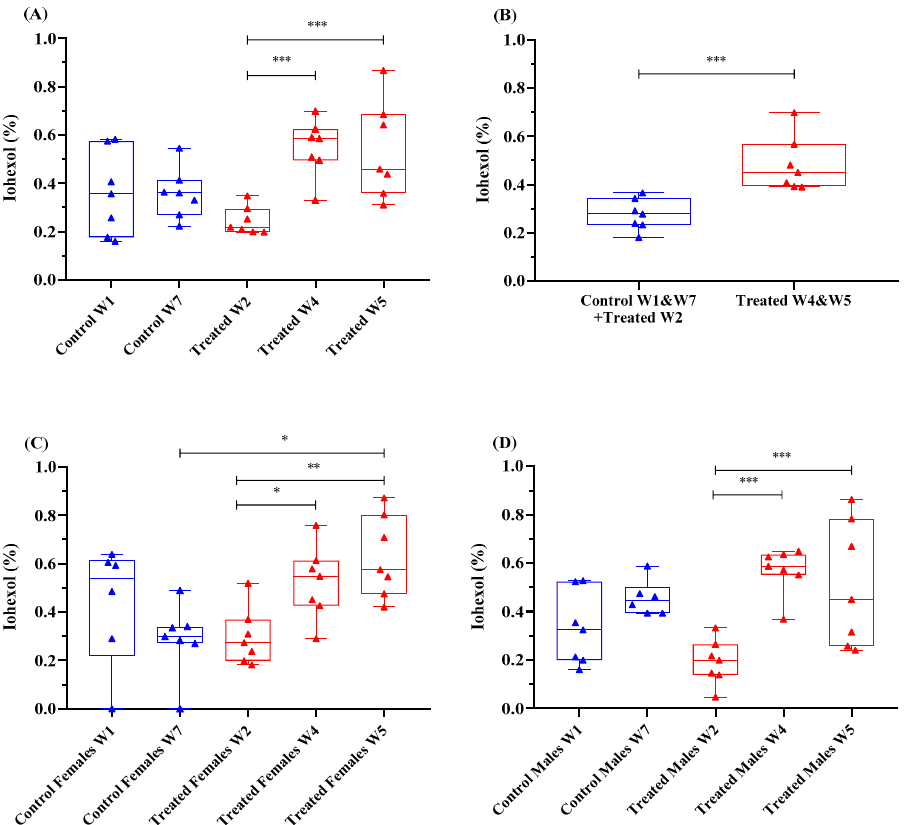
Figure 3. Urinary excretion of iohexol (%) during 24 h following oral administration in all mice ( A , B ) and ( C ) female and ( D ) male mice over 24 h, with data combined for the 7 weeks of intestinal permeability testing. Data are presented on a base-10 log scale (Log10 (1 + x)). The horizontal line in the box is the median (50% percentile), and the upper and lower limits of the box indicate the 75% upper and 25% lower quartiles, respectively. The limits of the upper and lower vertical lines represent the maximum and minimum data results, respectively. Dots represent each of the seven urinary collection time points during the 24 h period. * p < 0.05, ** p < 0.01, *** p < 0.001. When combining the data from all measurement time points during the study, there was no significant difference in the urinary excretion of iohexol between male and female mice ( p = 0.532). In female mice, there was a significant difference in the urinary excretion of iohexol between treated mice in W2 and W4 ( p = 0.048) and W2 and W5 ( p = 0.002) and between control mice in W7 and treated mice in W5 ( p = 0.033) (Figure 3C, Table S3). In male mice, a significant difference in the urinary excretion of iohexol occurred in treated mice between W2 and W4 ( p < 0.001) as well as between W2 and W5 ( p < 0.001) (Figure 3D, Table S3). In control and treated mice, there was a significant difference in the urinary excretion of iohexol between the seven urinary collection time points ( p < 0.001). In both treated and control mice, the urinary excretion of iohexol peaked at 4 h. There was also a second and less pronounced increase at 24 h in control mice and in treated mice only when IP was tested in W4 and W5 (Figure 4A,B, Tables 1 and S4). These increases in the urinary excre- tion of iohexol at 4 h and 24 h were higher in the treated mice in W4 and W5 than in the treated mice in W2 and the control mice. At 4 and 24 h, the strongest significant differences in the urinary excretion of iohexol occurred between W2 and W4 ( p = 0.003, p = 0.007,